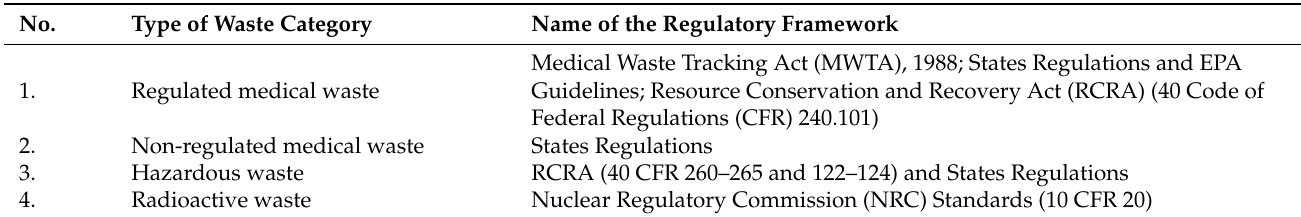
Table 3. Regulatory framework and categorisation of medical waste in the